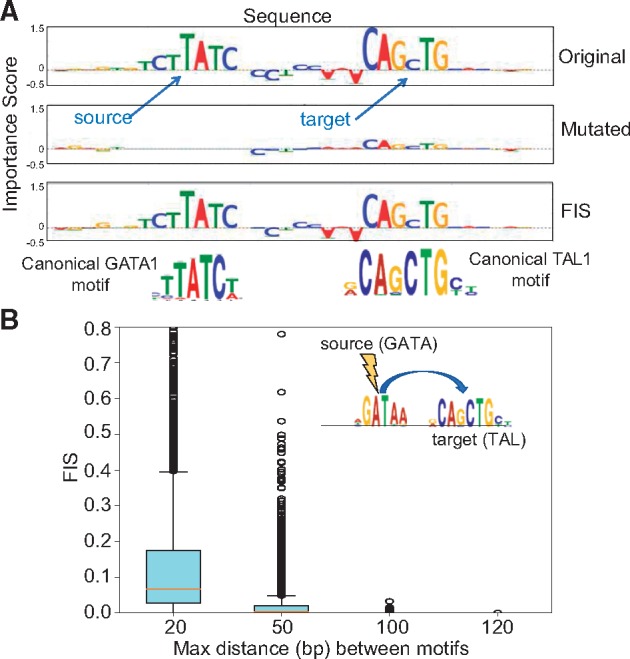
(A) Example sequence showing interaction between GATA and TAL motif. Top row shows the importance scores for the original sequence. When the source GATA motif is mutated, the feature importance of the target TAL1 motif drops (second row) indicating a strong interaction between the two motifs (high FIS) (third row). (B) Distribution of FIS scores for GATA1-TAL1 motif pairs stratified by relative distance between motifs. GATA1 motifs exhibit strong interactions with TAL1 motifs that are within 20 bp distance